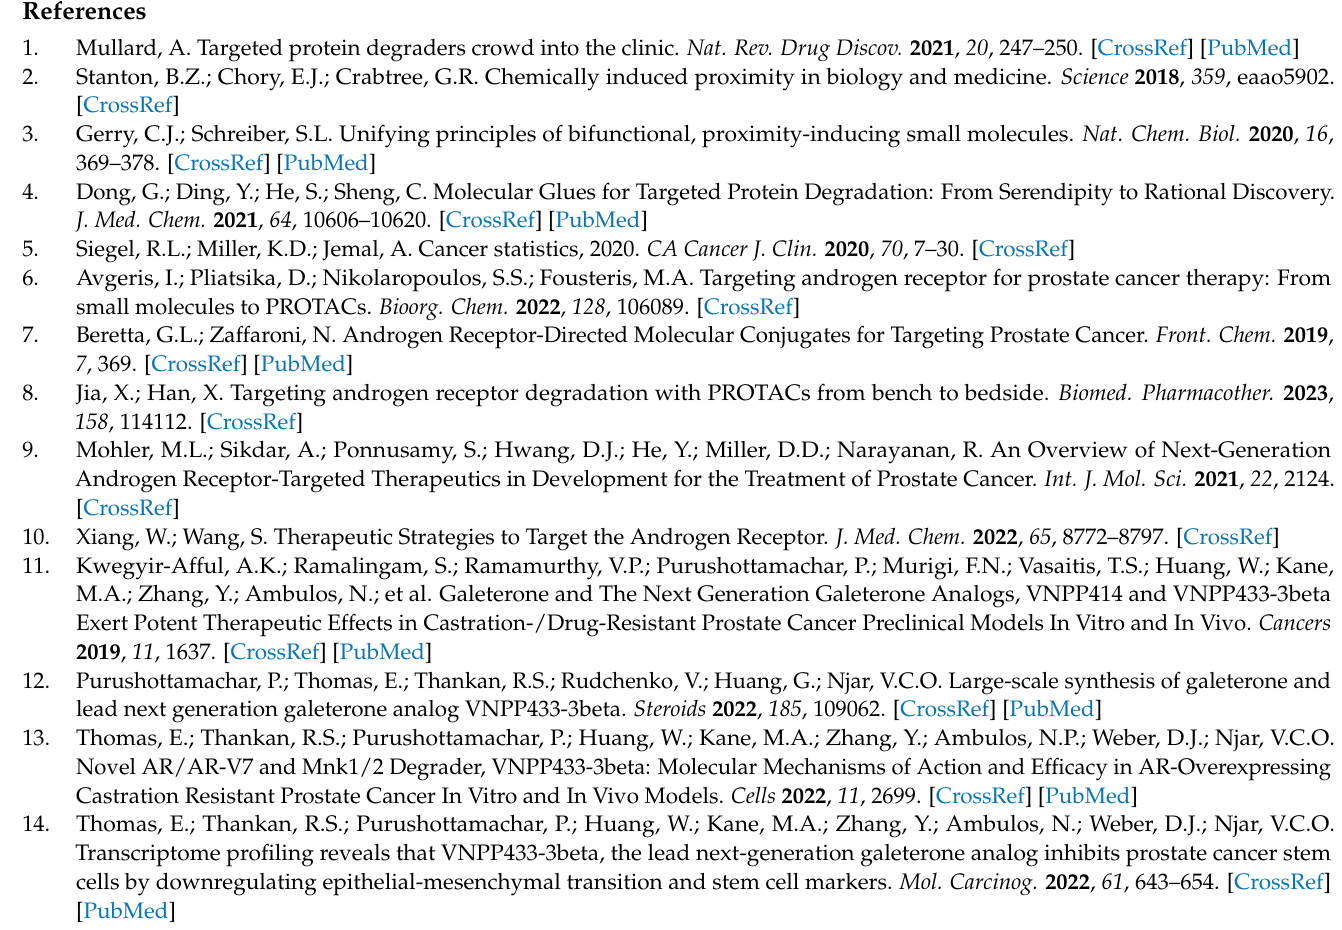
Figure S2: The uncropped blots of Figures 2 and